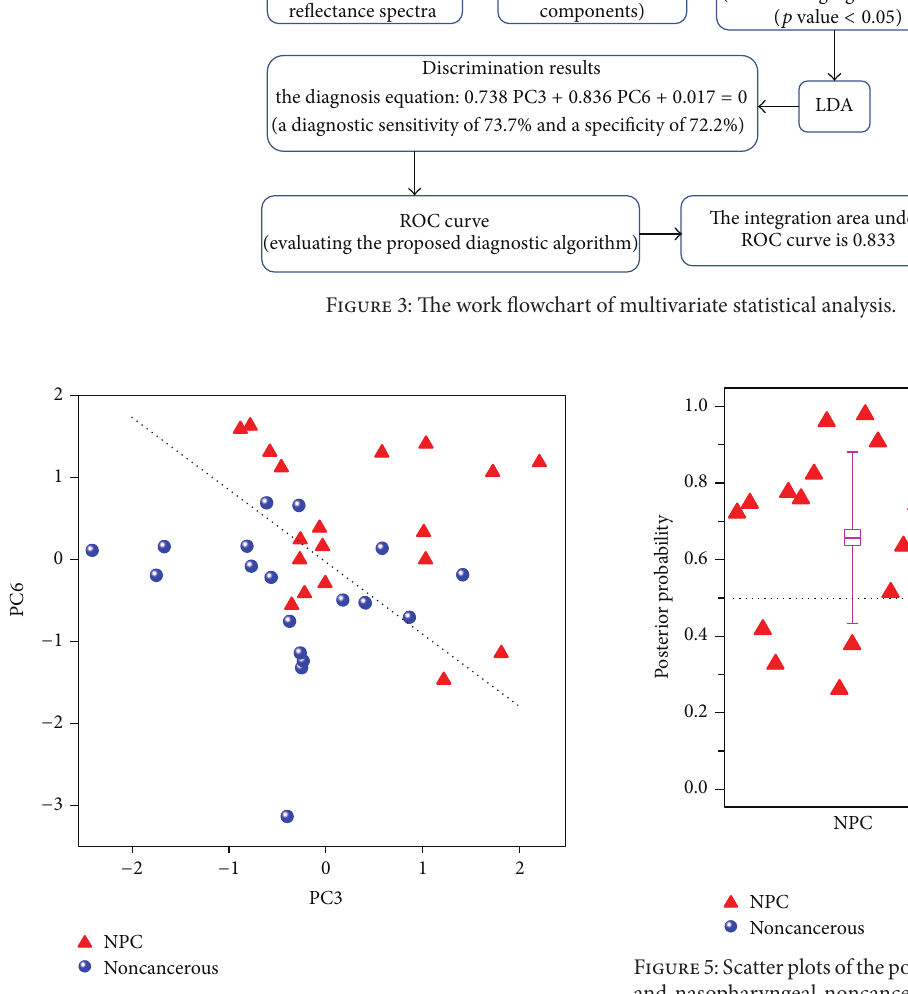
Figure 4: A two-dimension scattered point diagram of the PCA result for NPC group (red triangles 󳵳 ) and noncancerous group (blue circle e ). The dotted lines (0.738 PC3 + 0.836 PC6 + 0.017 = 0) served as a diagnostic method for NPC sample and noncancerous sample differentiation.